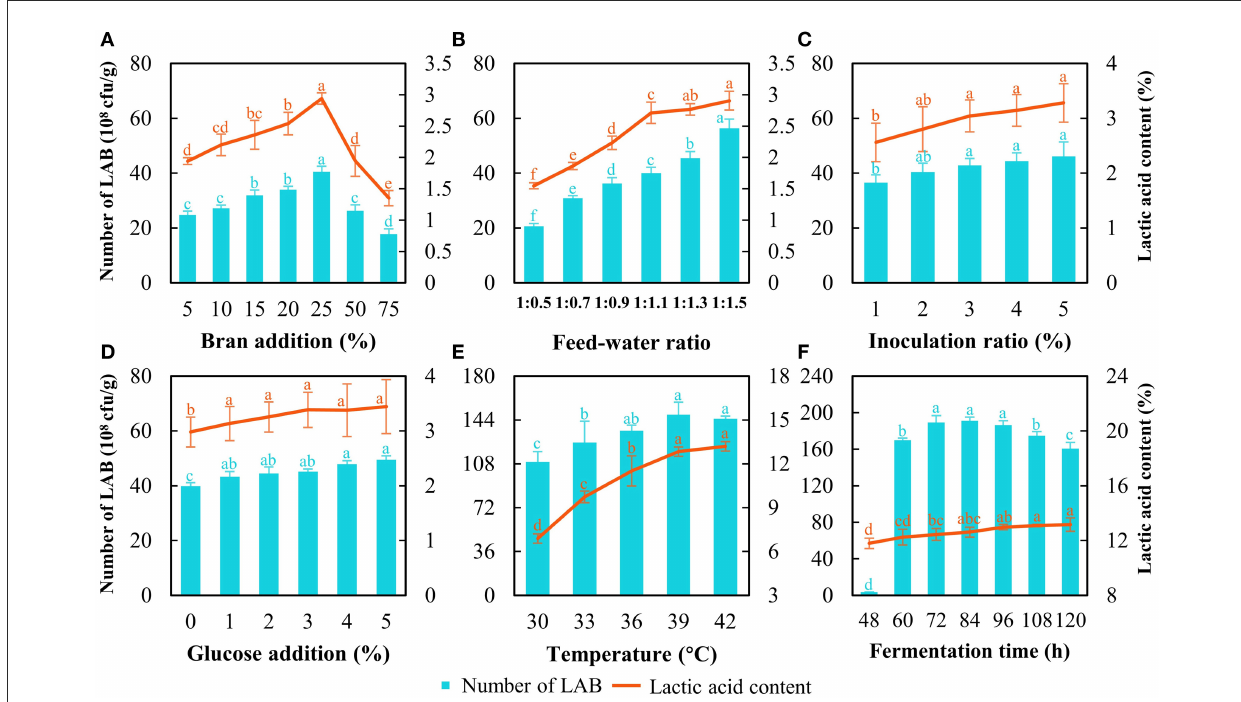
FIGURE2 Optimization of SSF to produce fermented astragalus by detecting LAB count and lactic acid content. The factors include bran addition (A) , feed–water ratio (B) , inoculation ratio of L. pentosus Stm (C) , glucose addition (D) , fermentation temperature (E) , and fermentation time (F ) (one-way ANOVA was performed to evaluate the difference). The same letter showed no significant difference between the chosen groups, while the different letters revealed that significant difference existed between the chosen groups.